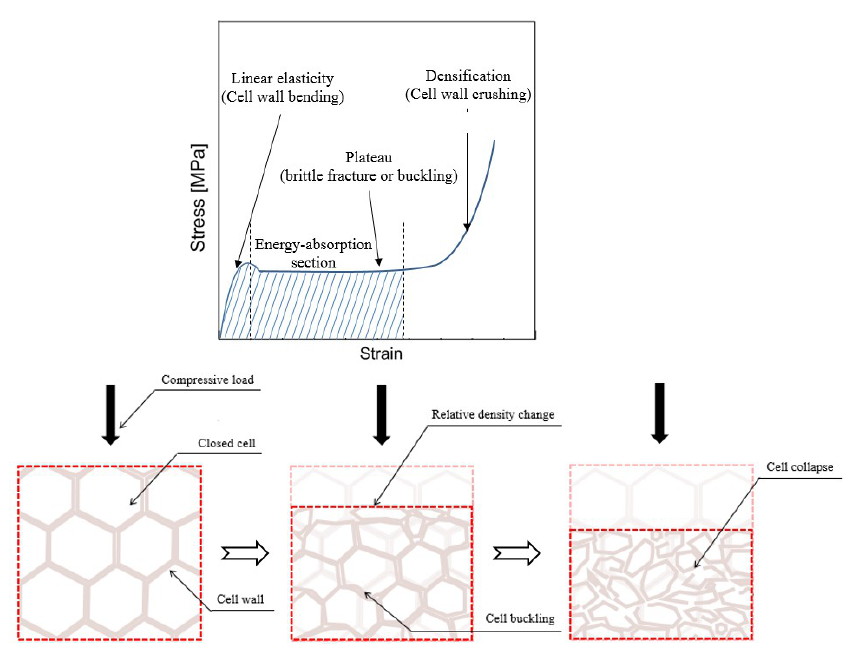
Figure 3. Mechanical behavioral characteristics of rigid PUF under a compressed load.